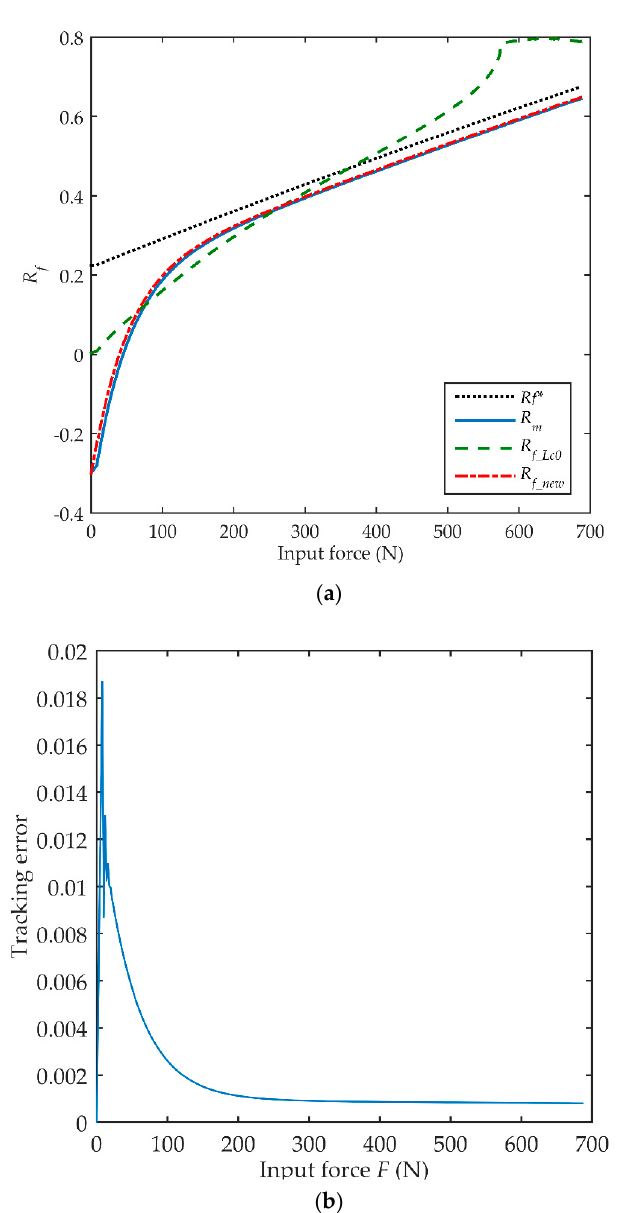
Figure 6. The design result: ( a ) comparison of the traces of R f *, R m , R f _ new , and R f _ Lc0 ; ( b ) the tracking error between R m and R f _ new .